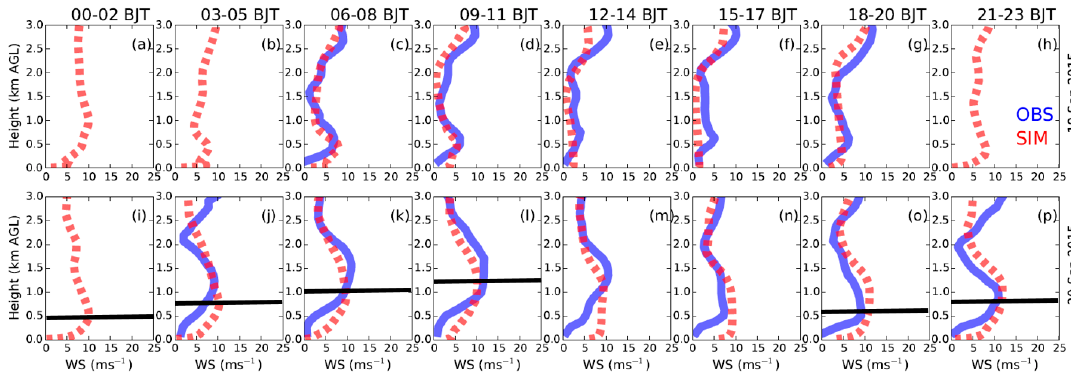
Figure 2. Three-hourly averaged profiles of wind speed (left to right) from 00:00 to 23:00 h Beijing time (BJT) derived from wind-profiler observations (in blue) and WRF-Chem simulations (in red) in Beijing on ( a – h ) 19 September and ( i – p ) 20 September 2015. The locations of jet nose are marked by the black lines based on the simulated profiles. The simulations are derived from the nearest grid point to the wind-profiler site. Int. J. Environ. Res. Public Health 2019 , 16 ,